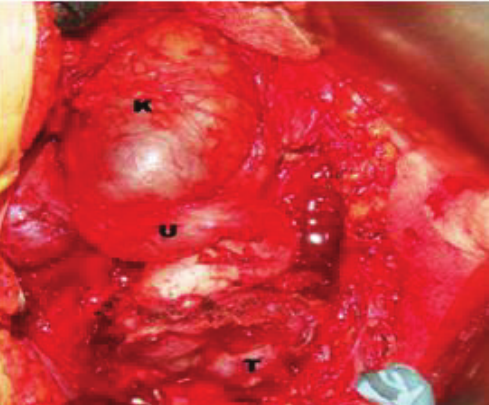
Figure 3: Intraoperative image showing gross hydroureteronephrosis with tortuous ureter and tumor with ureteric encasement.